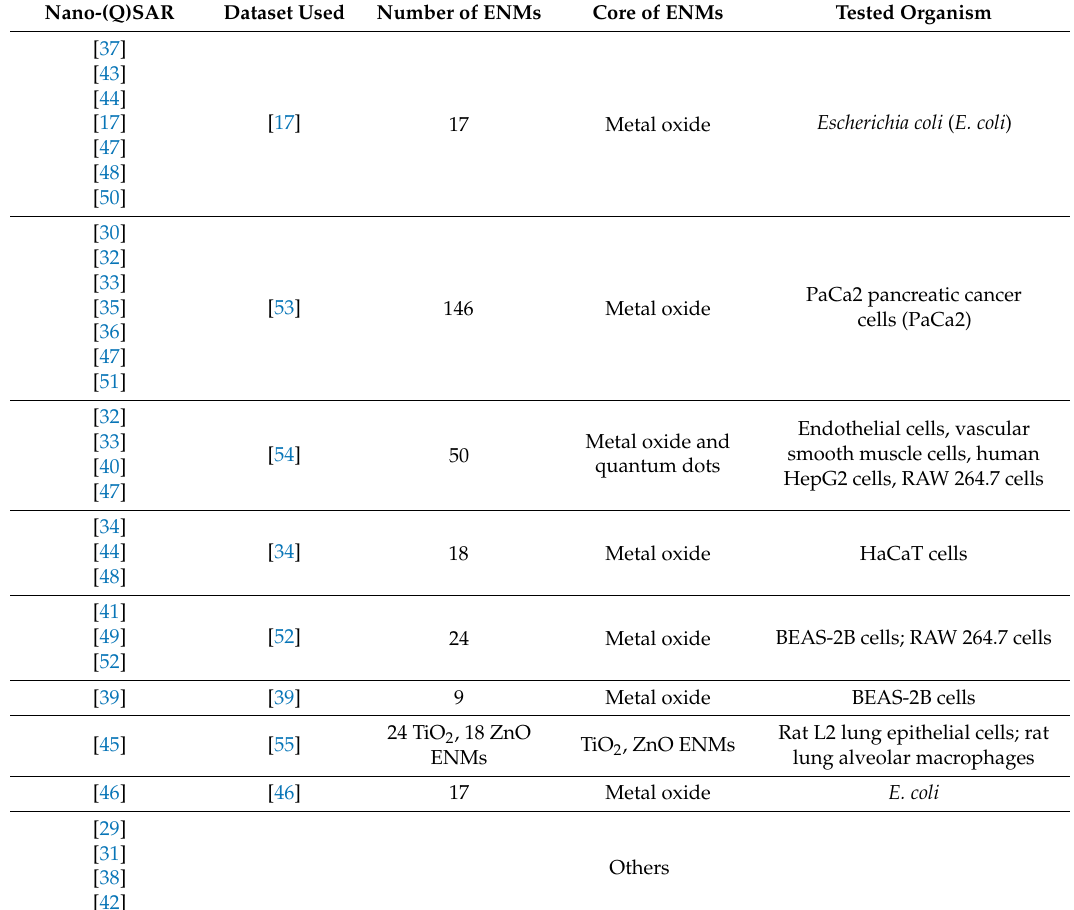
Table 2. Summary of the experimental data of ENMs used in nano-(Q)SAR